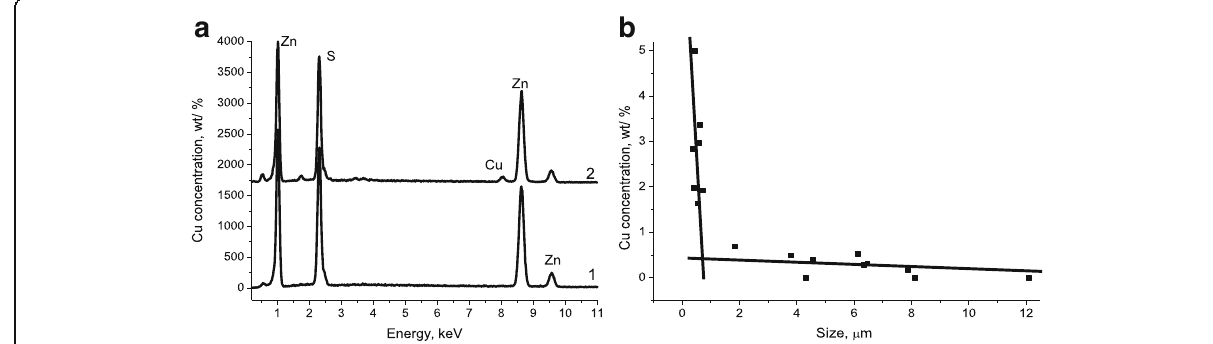
Fig. 3 a EDS spectra of ZnS – SHS particles with sizes: 1 – 27 μ m, 2 – 0.3 μ m. b Concentration of Cu in dependence of ZnS – SHS particles